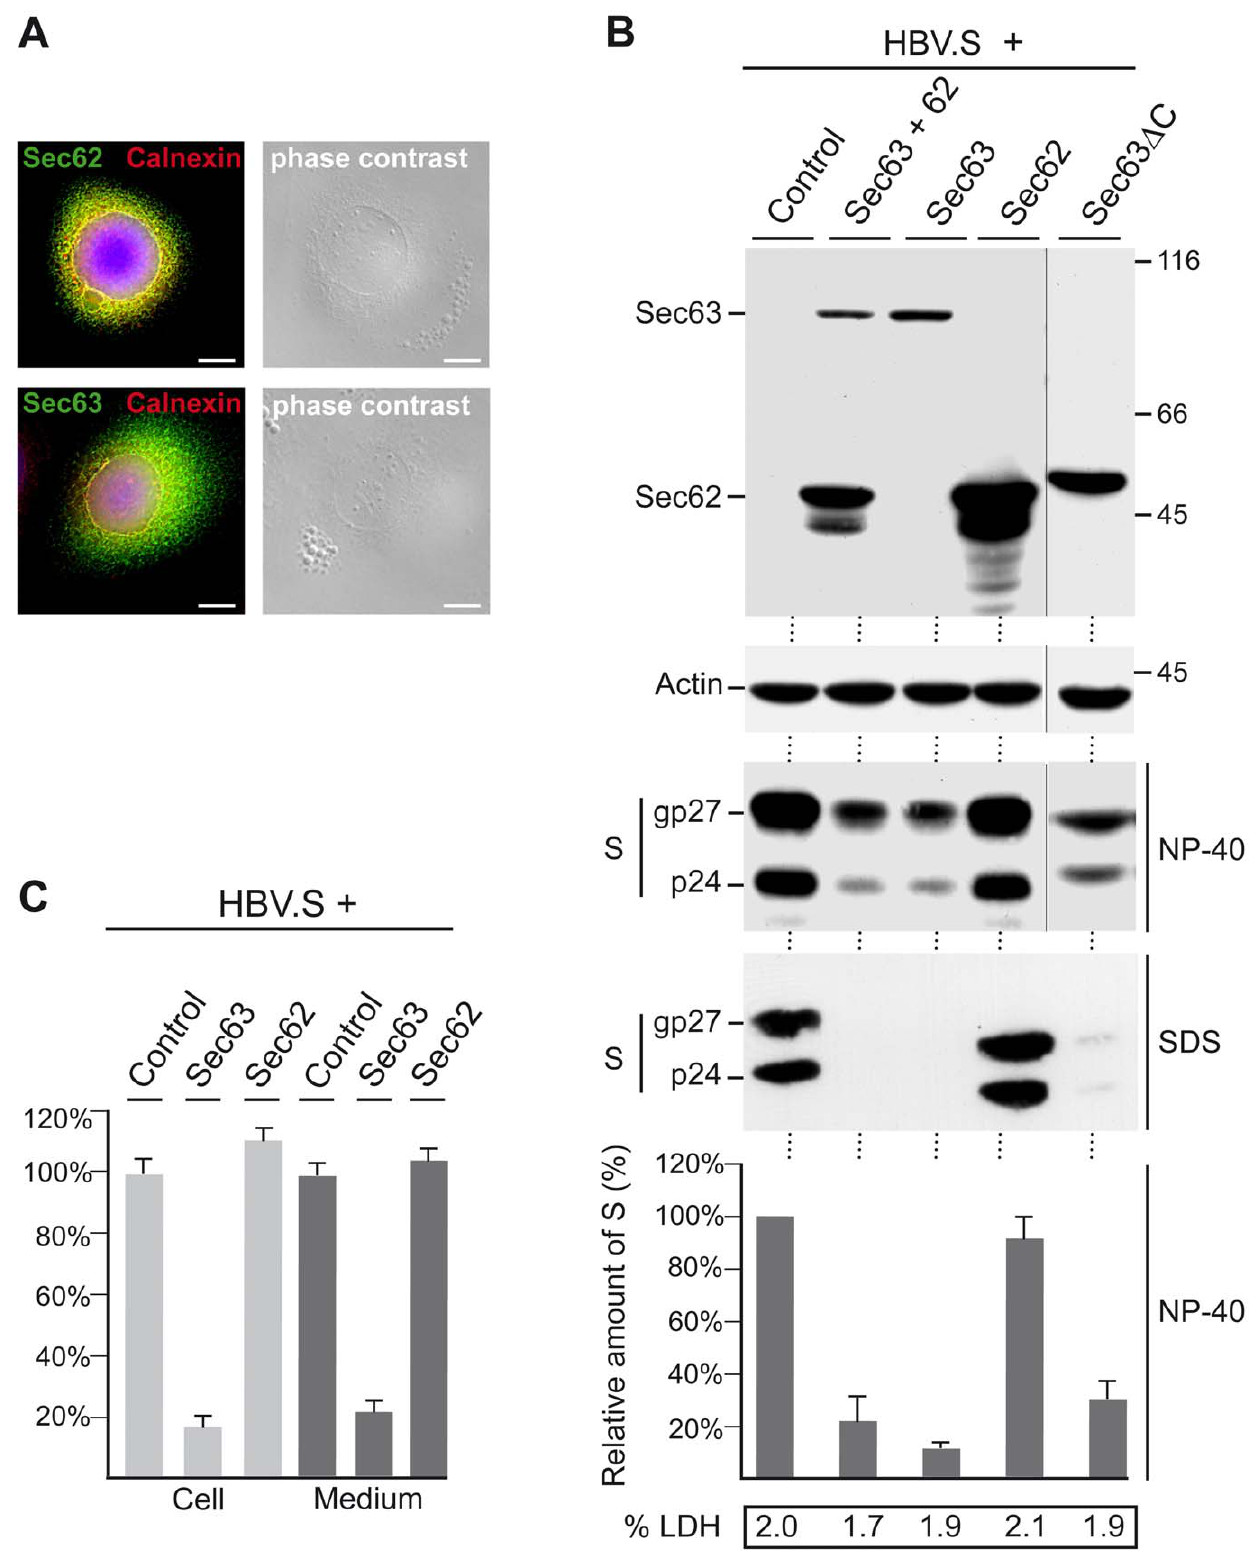
Figure 1. Overexpressing of Sec63 reduces the steady-state HBV.S level. A. HuH-7 cells were transfected with Myc-tagged Sec62 or Sec63 and immunostained with mouse anti-Myc and rabbit anti-calnexin antibodies. After staining with AlexaFluor 488-conjugated anti-mouse and AlexaFluor 546-conjugated anti-rabbit antibodies, cells were visualized by deconvolution fluorescence microscopy. The overlays of the fluorescences are shown with yellow colour indicating colocalization. DNA staining of the nuclei is in blue. The corresponding phase contrast images depicting